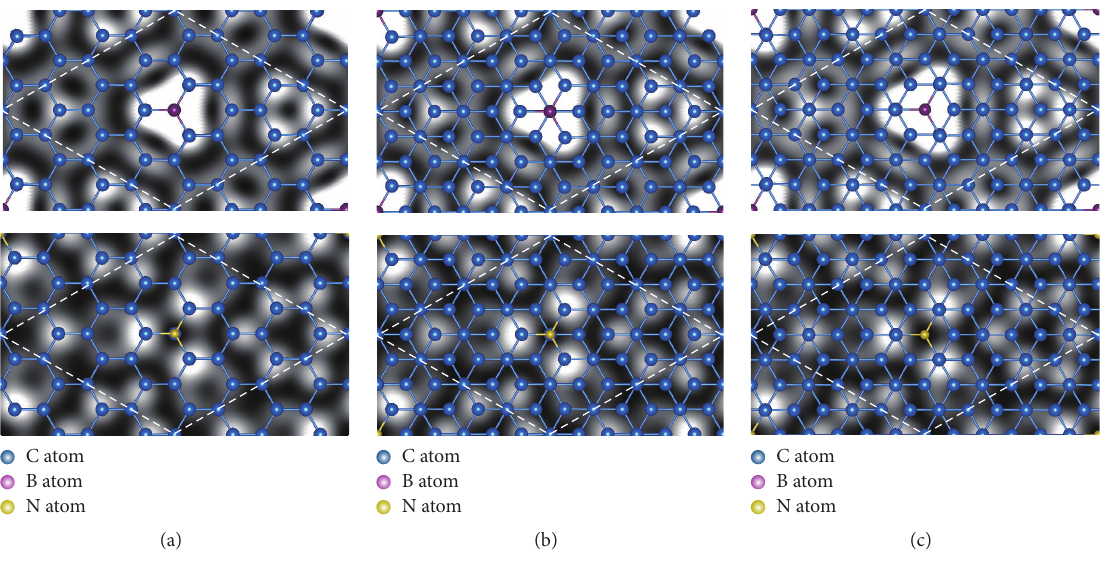
Figure 8: Simulated STM images of (a) AA -, (b) AB1 -, and (c) AB2 -stacked bilayer graphenes doped with B atom (upper panel) and N atom (lower panel). The STM images for B-doped and N-doped cases are shown at the applied bias voltages of +0.5eV and − 0.5 eV, respectively. Reproduced with permission from [57], copyright 2015,